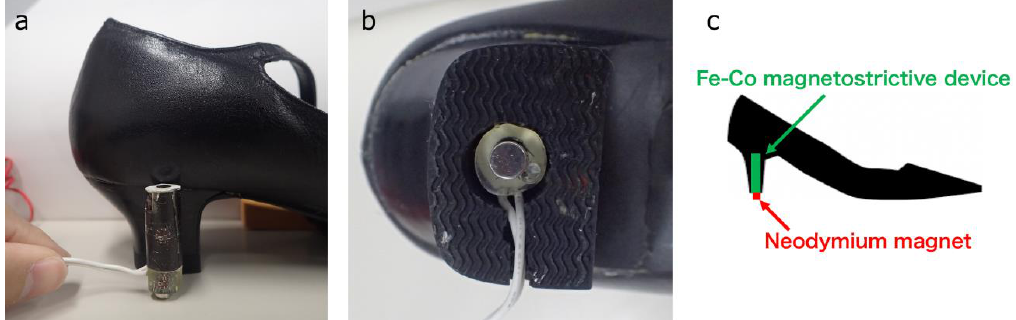
Figure 2. Integrated position of Fe–Co magnetostrictive device into a hollowed heel of the left pump. ( a ) side view, ( b ) bottom view, and ( c ) schematic illustration of Fe–Co magnetostrictive fiber integrated shoe.